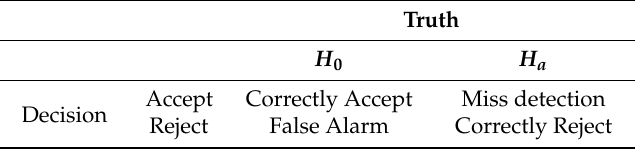
Table 1. The decision matrix of the general hypothesis